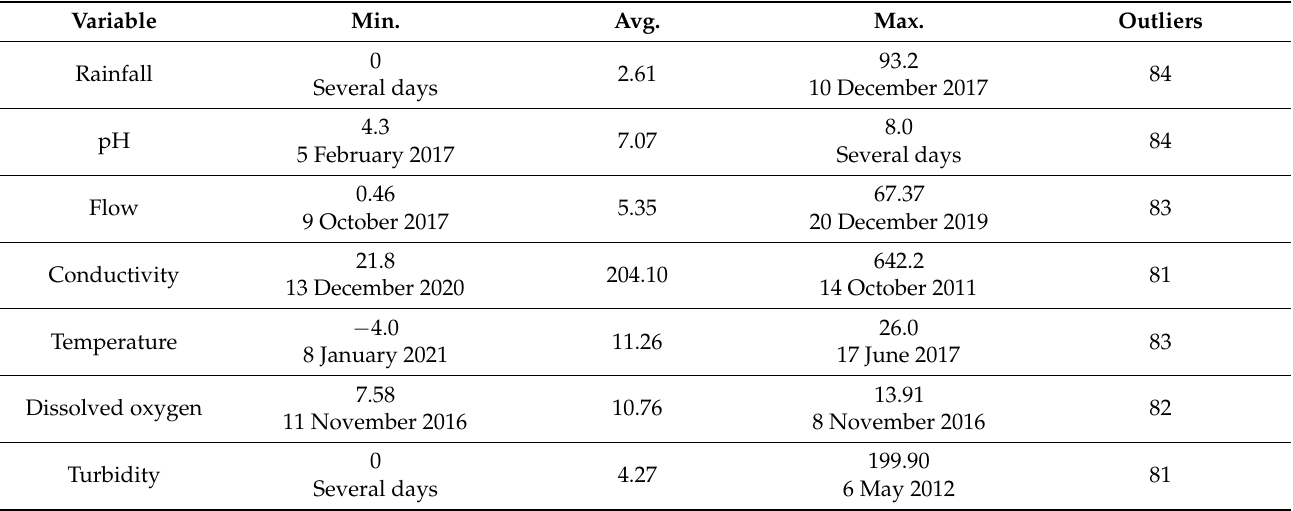
Table 3. Results of the functional analysis on all variables. The first column contains the name of each variable. Columns 2 to 4 include information on the minimum, average, and maximum values for their respective variables. Lastly, column 5 contains the number of weeks identified as outliers in each variable out of the 620 analyzed.